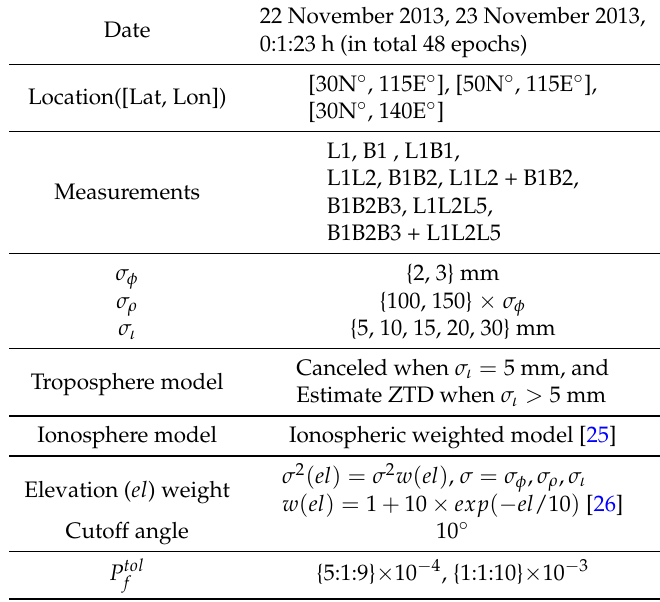
Table 1. The setup of the Monte Carlo simulations. ZTD, Zenith Troposphere